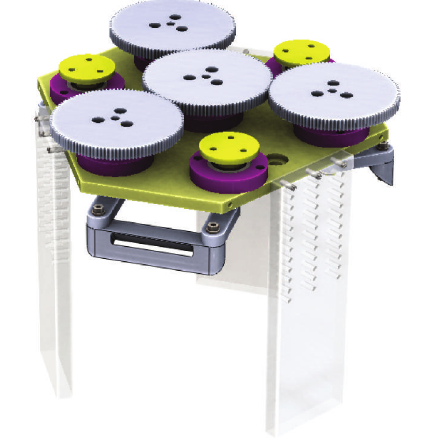
Figure 9: 3D simulation of the actual RGB mixing